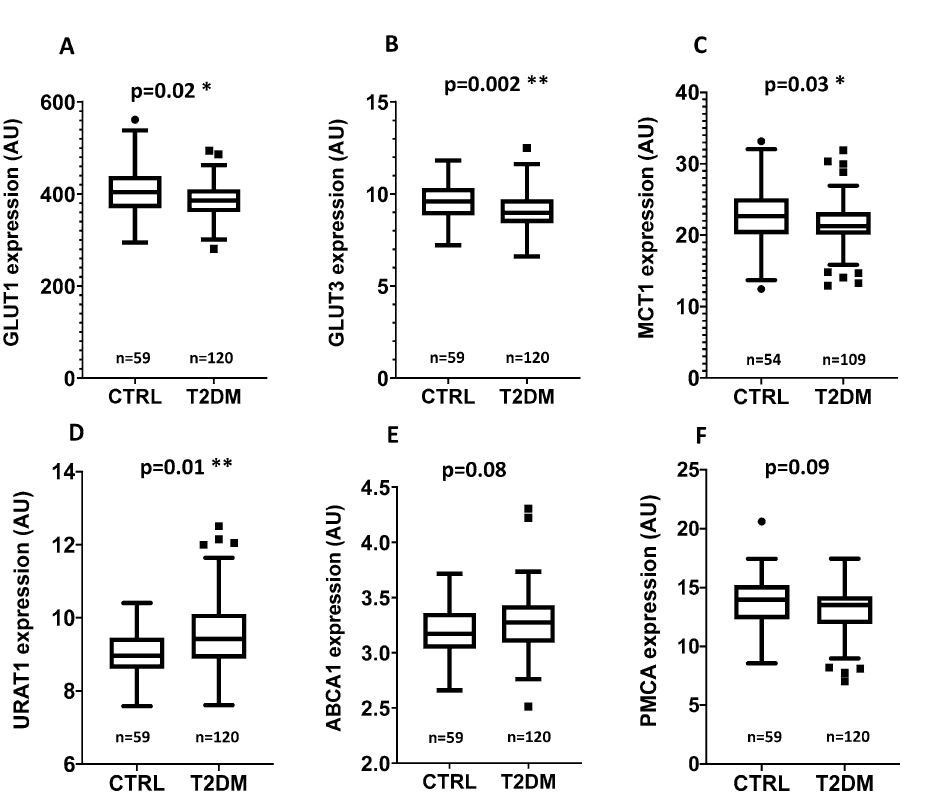
Figure 1. Expression of the RBC membrane proteins in age-matched control subjects and in T2DM patients, measured by flow cytometry. ( A ) GLUT1, ( B ) GLUT3, ( C ) MCT1, ( D ) URAT1, ( E ) ABCA1, ( F ) PMCA4b. The AU (arbitrary unit) values were calculated as described in the “Methods”. The p values were calculated by the Mann–Whitney test. The number of participants (n) is listed in each